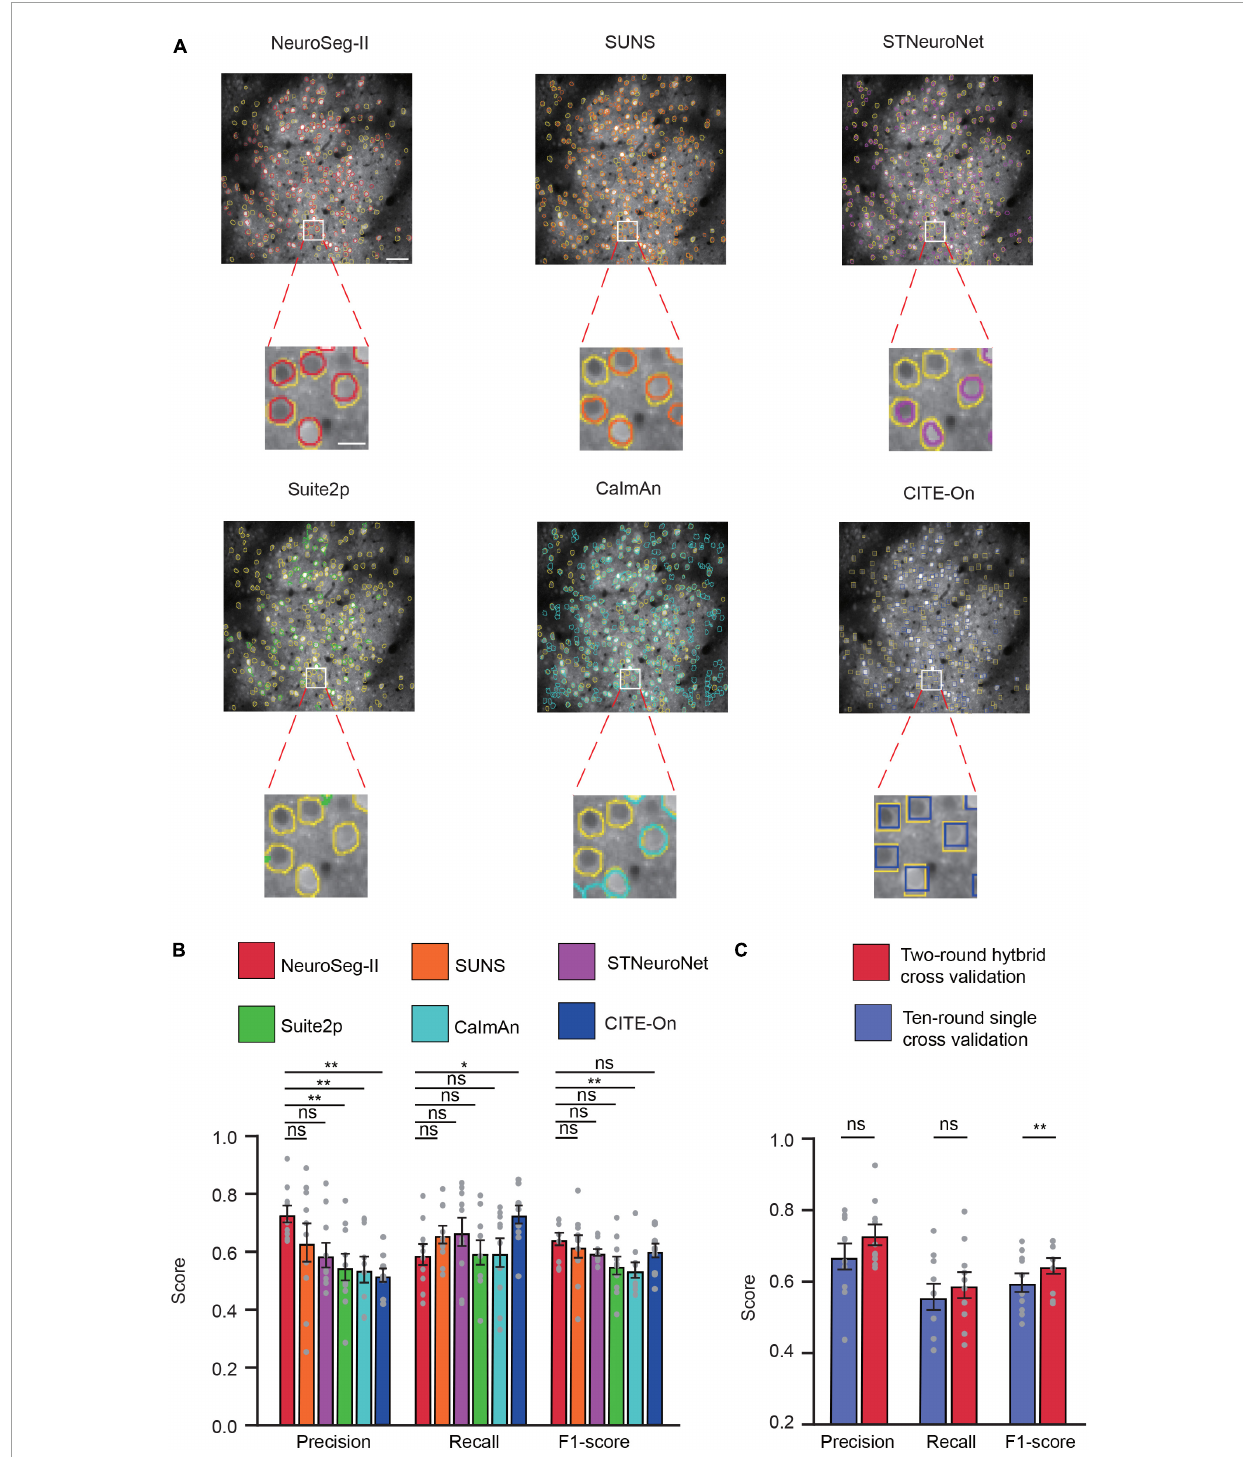
FIGURE8 NeuroSeg-II outperformed other neuron segmentation methods in accuracy on the Neurofinder dataset. (A) Top: Examples from the Neurofinder dataset (video 02.00) showing the neuron segmentation results of NeuroSeg-II (precision: 0.8272; recall: 0.6054; F1-score: 0.6991), SUNS (precision: 0.7482; recall: 0.6341; F1-score: 0.6865), STNeuroNet (precision: 0.5096; recall: 0.7669; F1-score: 0.6124), Suite2p (precision: 0.7014; recall: 0.3633; F1-score: 0.4787), CaImAn (precision: 0.5301; recall: 0.6978; F1-score: 0.6025), and CITE-On (precision: 0.5191; recall: 0.8395; F1-score: 0.6415), where the segmented neurons are overlaid on the fused image data. Scale bar, 50 µ m. The yellow outlines indicate the GT neurons, and the other colors indicate the neurons found by the methods. Bottom: Examples of segmented neurons zoomed in on the white-boxed regions. Scale bar, 5 µ m. (B) Statistical comparison of NeuroSeg-II with other methods (* P < 0.05, ** P < 0.01; n = 10 images or videos; ns, not significant; and error bars are SEM). (C) Statistical comparison of two-round hybrid cross validation with 10-round single cross validation by NeuroSeg-II (** P < 0.01; n = 10 images; ns, not significant; and error bars are SEM). All P -values were calculated with a two-sided Wilcoxon signed-rank test. The gray dots represent the scores for each testing